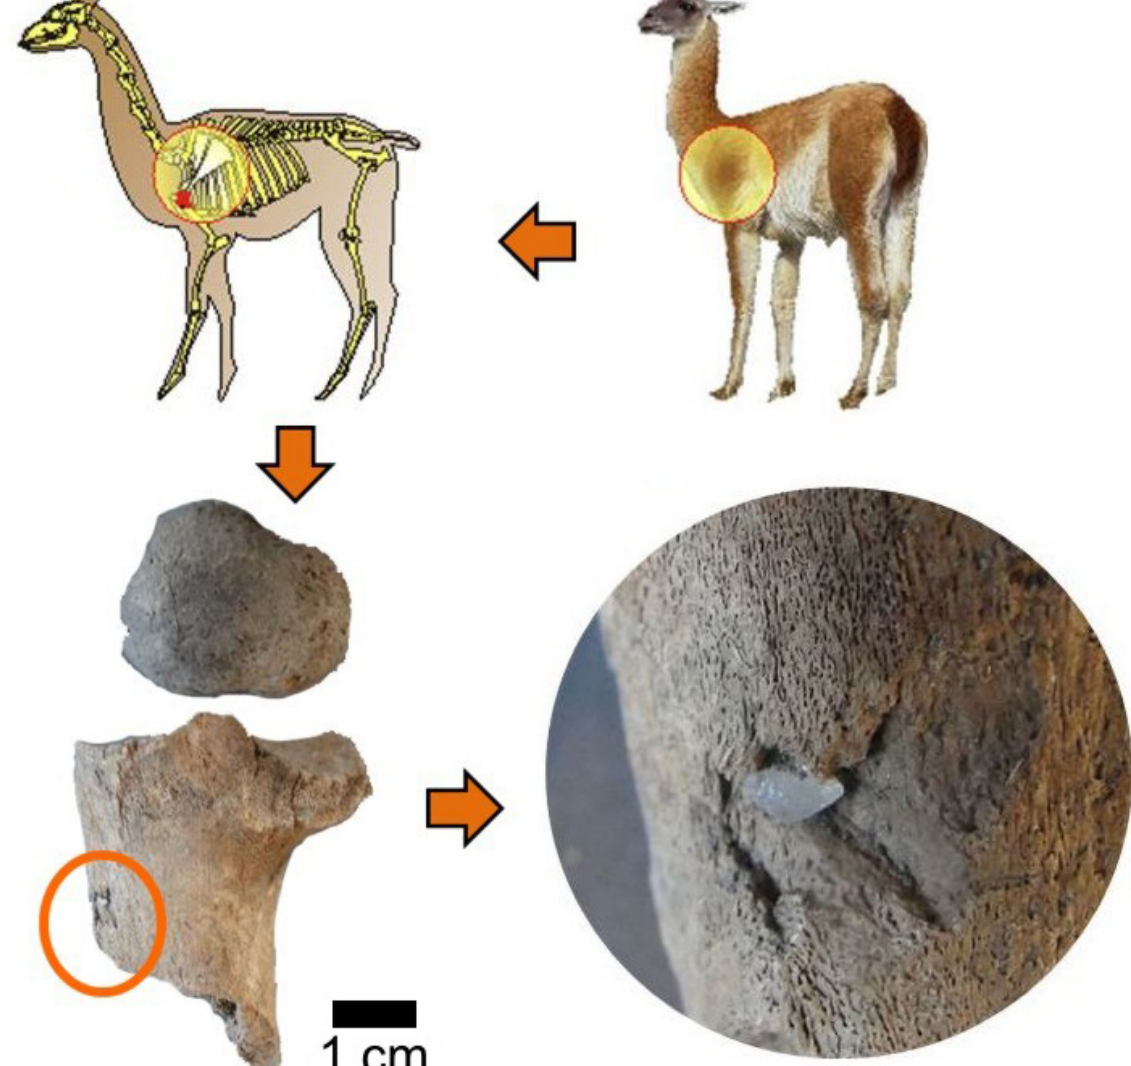
Figure 6. Bone specimen of new-born guanaco with embedded